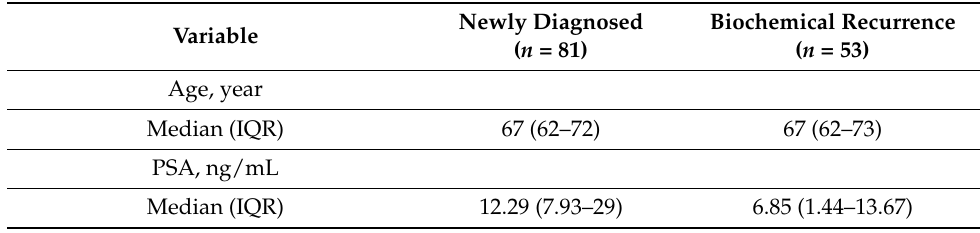
Figure 1. Study flow chart. All patients were diagnosed with biopsy-proven prostate cancer and all patients underwent a WB-MRI and a PSMA PET-CT at the University Clinic Saint-Luc Brussels from August 2016 to November 2019. PCa: prostate cancer; WB-MRI: whole body magnetic resonance imaging; PSMA PET-CT: prostate specific membrane antigen positron emission tomography; ND: newly diagnosed; BCR: biochemical recurrence. Table 1. Patient demographics, disease characteristics and primary